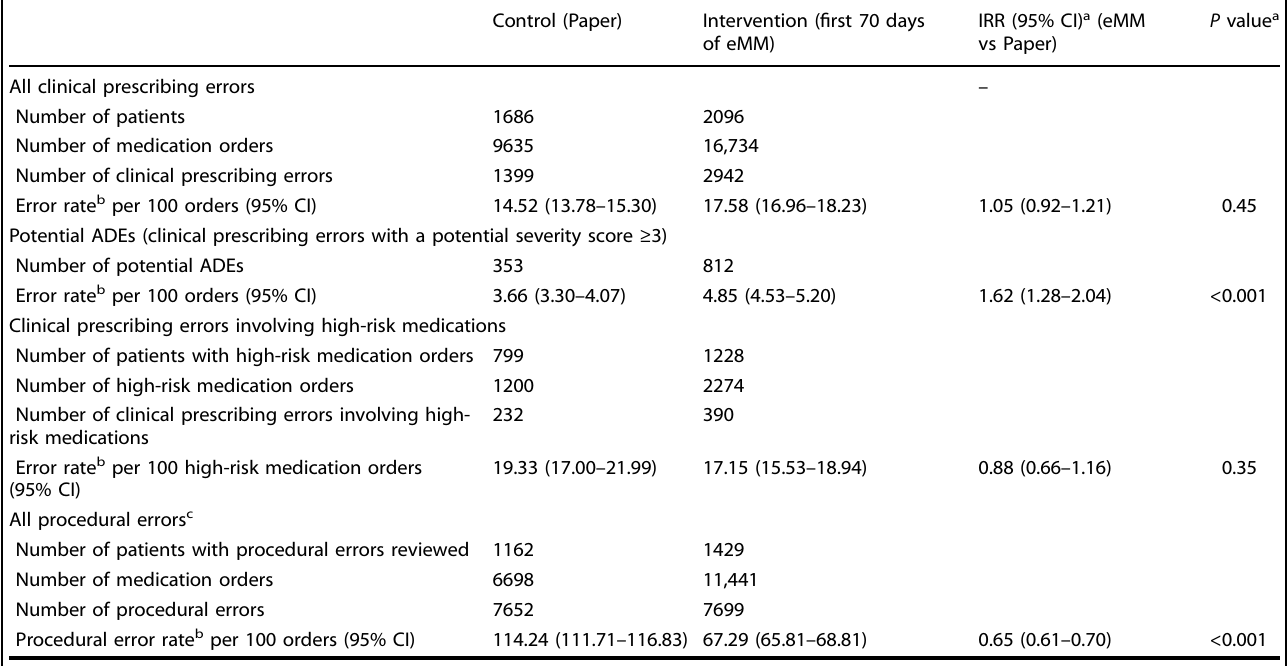
Table 2. Prescribing crude error rates and adjusted incidence rate ratios (IRRs) for the SWCRCT (short-term impact of eMM).